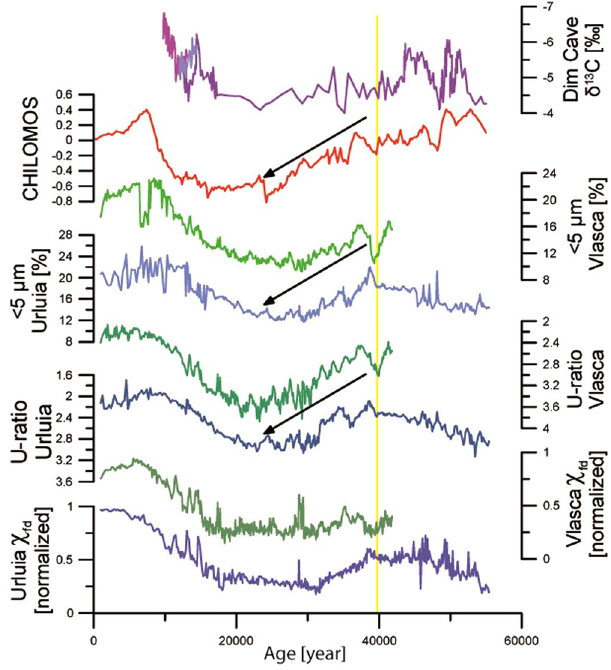
Figure 2. Direct comparison between proxies from the Urluia and Vlasca sections represented by U-ration, fine particles ( < 5 µ m) and χ fd (values are normalized), and their comparison with a stacked climatic record from northern China (CHILOMOS 34 ) and δ 18 O record from Dim Cave 36 over the past 55,000 years. The straight yellow line represents the timing of the Campanian Ignimbrite/Y-5 tephra deposition. Black arrows indicate a trend of general